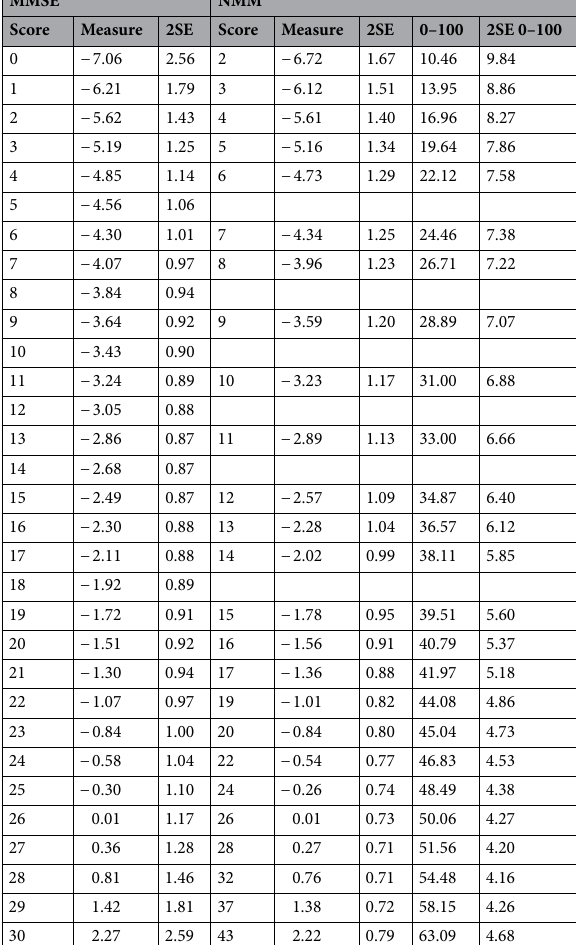
Table 4. Conversion table from MMSE to NMM (57 items) for both raw scores and measures (in logits) and converted into the 0–100 scale for NMM in Table 3. 2SE corresponds to measurement uncertainties with a coverage factor of